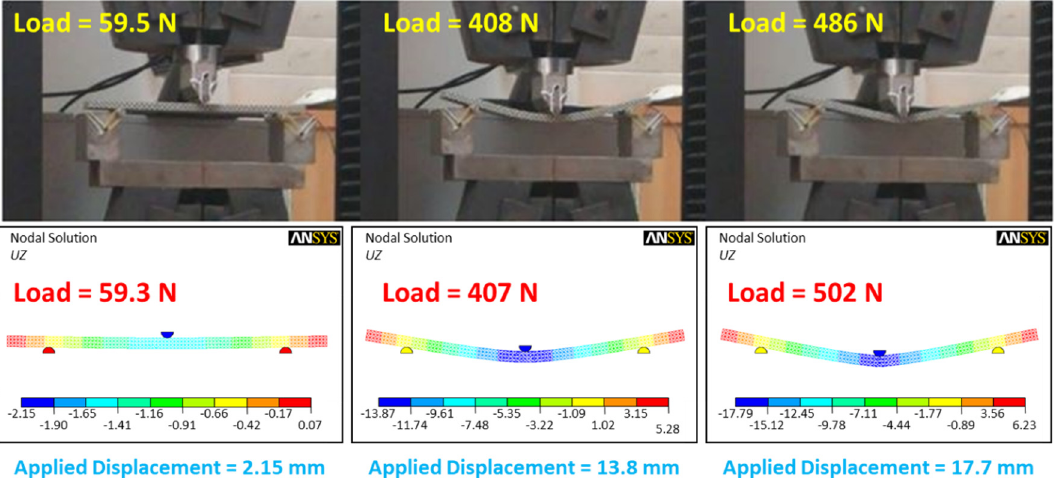
Figure 13. Experimental-numerical comparison in terms of deformed shape for specimen Type01. The numerical results reproduce the displacement along the loading direction.